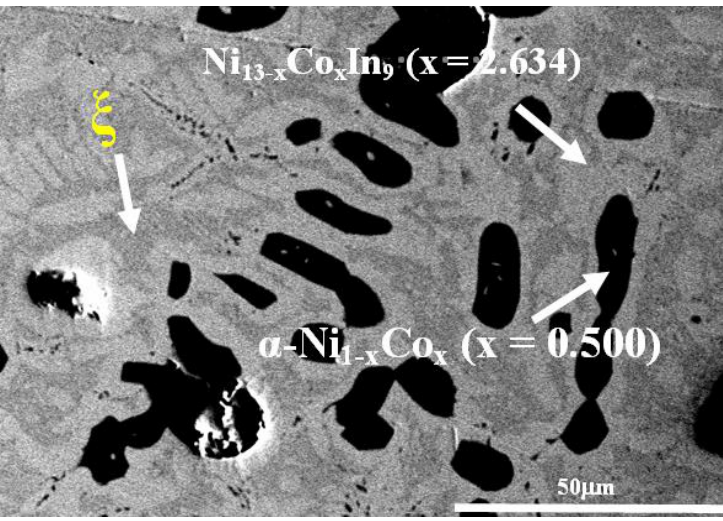
Figure 7. BSE micrograph of No. 28 (Co18Ni52In30).